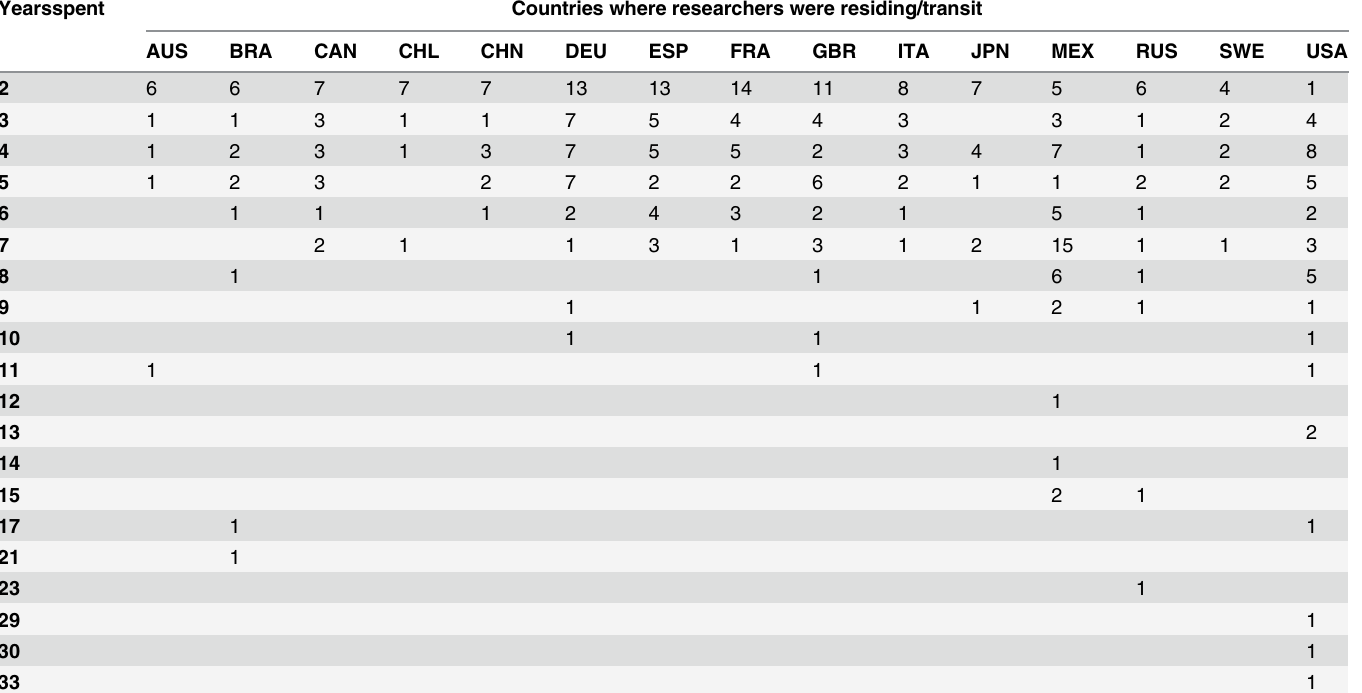
Table 15. Distributions of researchers in physics by years spent in foreign institutions.